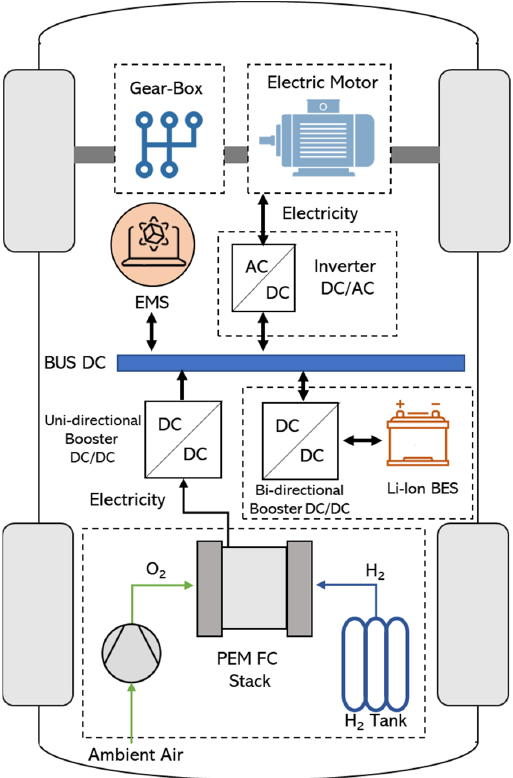
Figure 5. Fuel Cell Hybrid Electric Vehicle Configuration, with Fuel Cell and Battery Energy